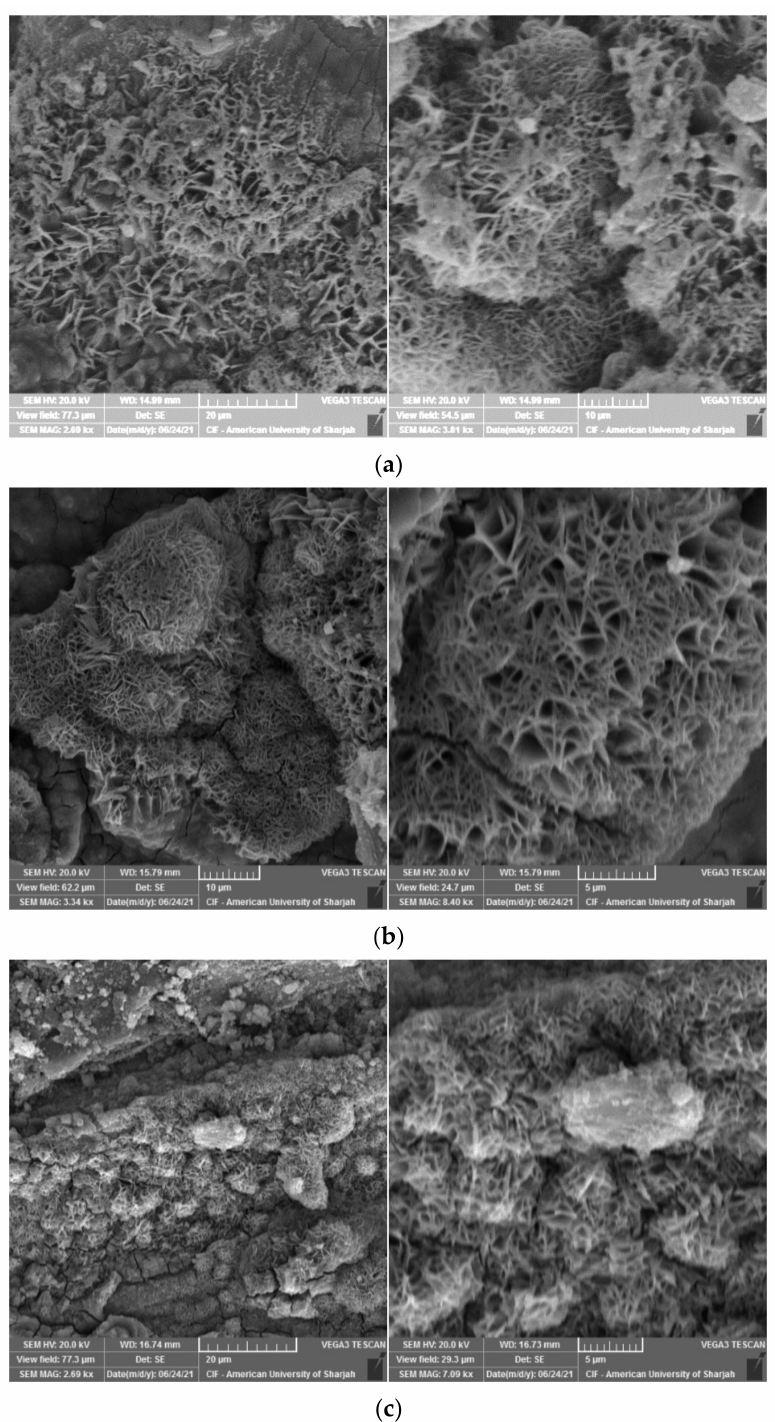
Figure 10. Iron oxide products spotted at 90 days of 24 h HAC specimens. ( a ) CNTRL mix; ( b ) GB30 mix; ( c ) GB15FA15